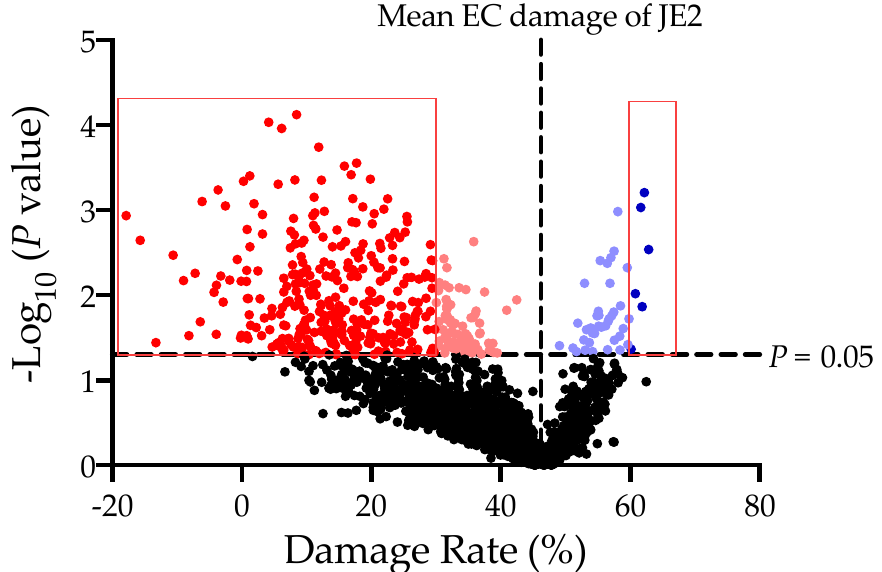
Figure 1. The global map of in vitro HMEC-1 damage rate caused by the mutant strains in the NTML. The vertical dashed line represents the mean of HMEC-1 damage rate of parental strain USA300 JE2 (46.19%); and the horizontal dashed line represents the p value of 0.05. The bright red dots represent ≤ 30% EC damage caused, while the bright blue dots represent ≥ 60% EC damage due to the study mutant strains in the NTML and p < 0.05 vs. JE2 WT strain. Damage rate below zero means the A 560nm of the test well is higher than the A 560nm of the negative damage control, which indicates that the mutant causes no damage to the EC. Table 1. Mutants significantly decrease HMEC-1 damage vs. JE2 WT strain (EC damage rate ≤ 30%). Locus